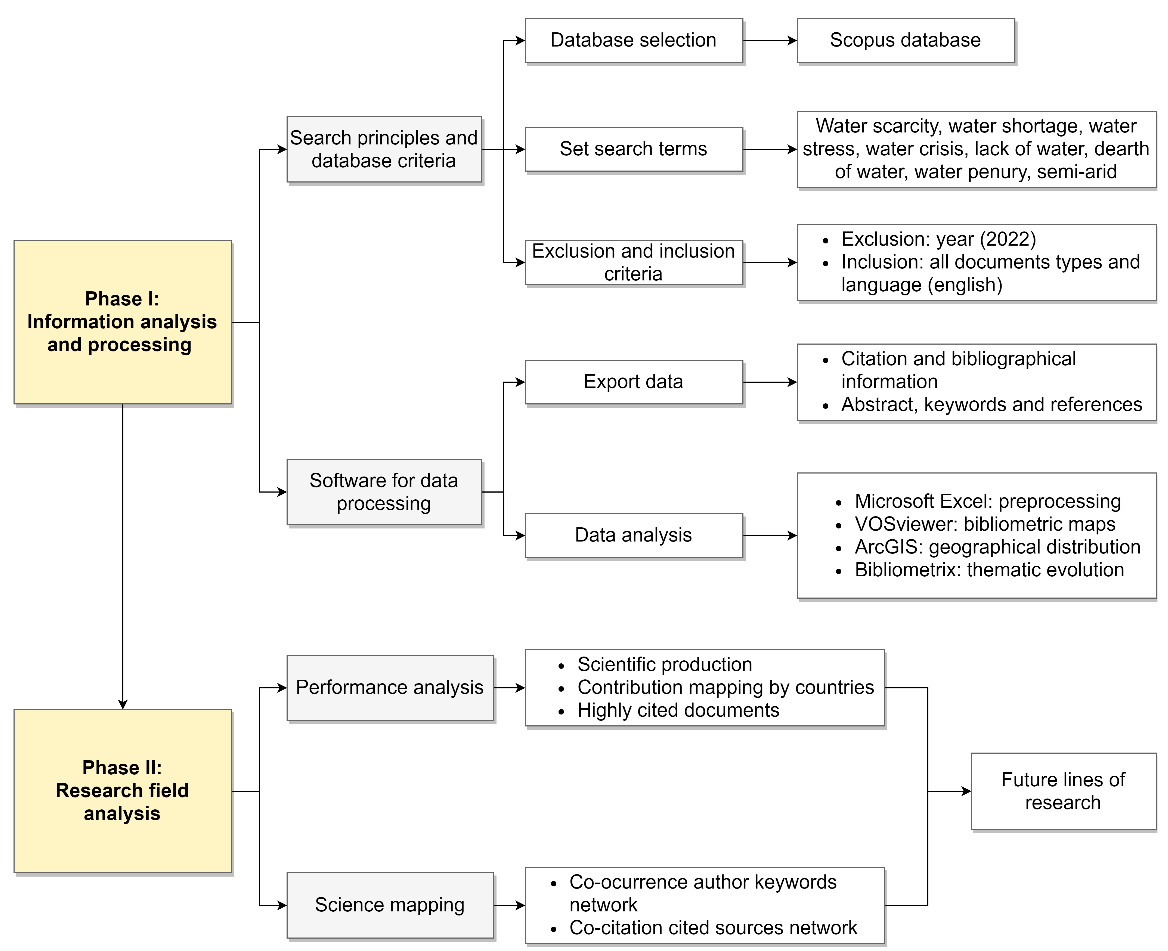
Figure 1. Outline of the research methodology.